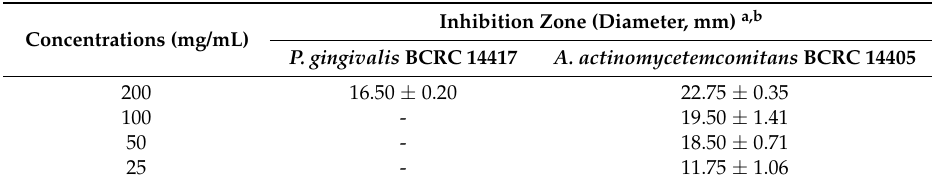
Table 2. Inhibition zone of NTU101FM ethanol extract against periodontal